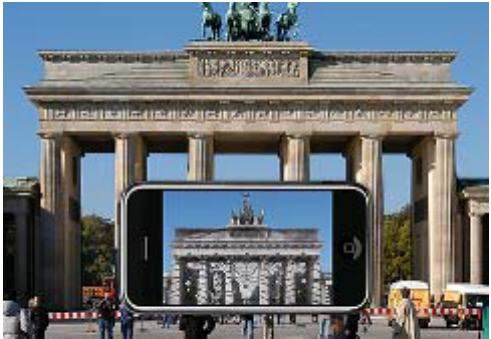
Figure 2. AR technology on the mobile navigation (Fraunhofer